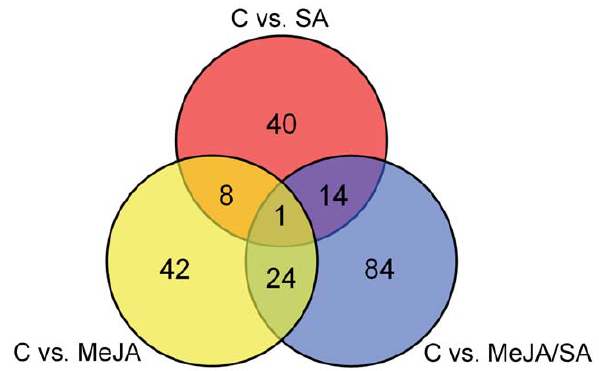
Figure 1. Venn diagram of differentially phosphorylated substrates upon treatment (MeJA, SA or SA/MeJA) versus control (C). The individual differentially phosphorylated peptides are shown in Table S1; peptides that are differentially phosphorylated after two or more treatments are represented in the table in subsequent rows. Of the nine (8 + 1) spots, differentially phosphorylated by both MeJA and SA, all were changed in the same direction, this was also observed for those that were differentially phosphorylated by SA/MeJA and overlap with SA or MeJA.